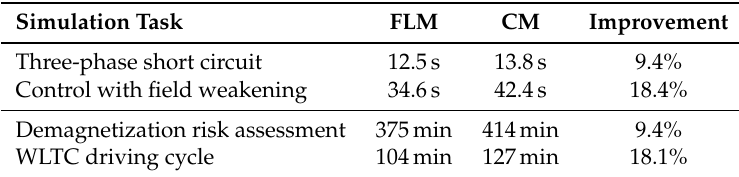
Table 3. Comparison of execution